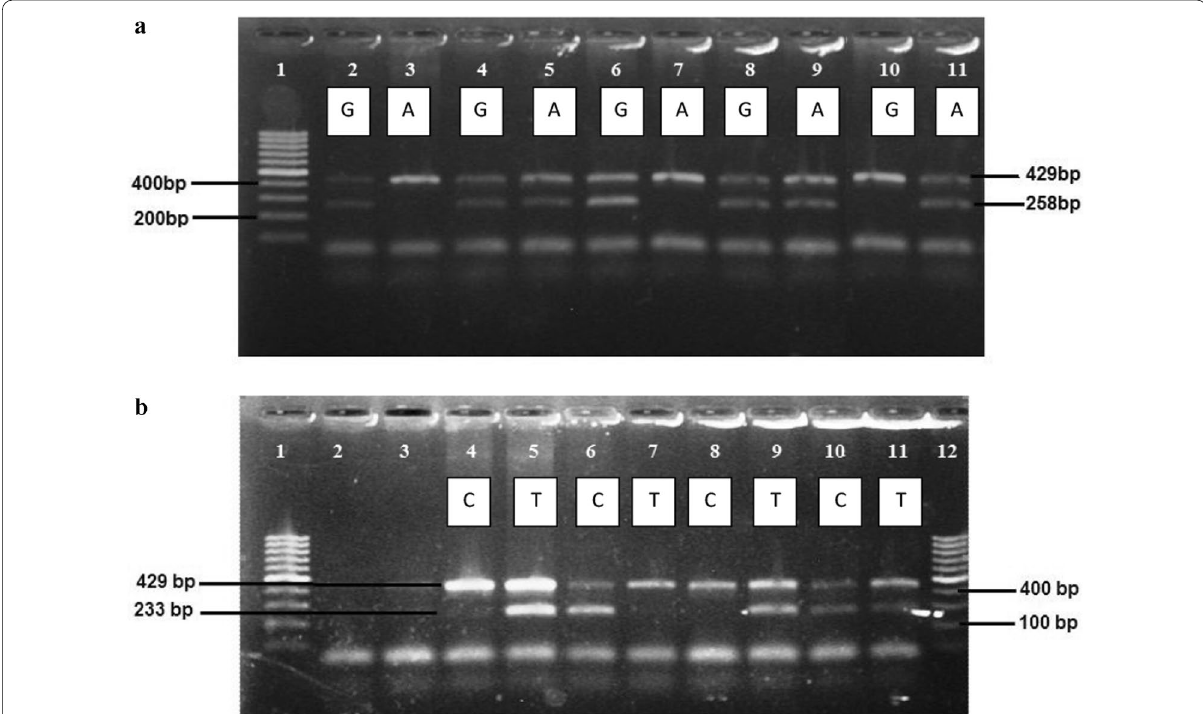
Fig. 1 a IL‑10 ( 1082G/A) PCR product. Lanes (2 and 3) and (6 and 7) are GG genotype; lanes (4 and 5) and (8 and 9) are GA genotype, lanes − (10 and 11) are AA genotype, and lane (1) represents 100 bp DNA ladder. b IL‑10 ( genotype, lanes (6 and 7) are CC genotype, lanes (10 and 11) have CT genotype, and lanes (1 and 12) represent 100 bp DNA